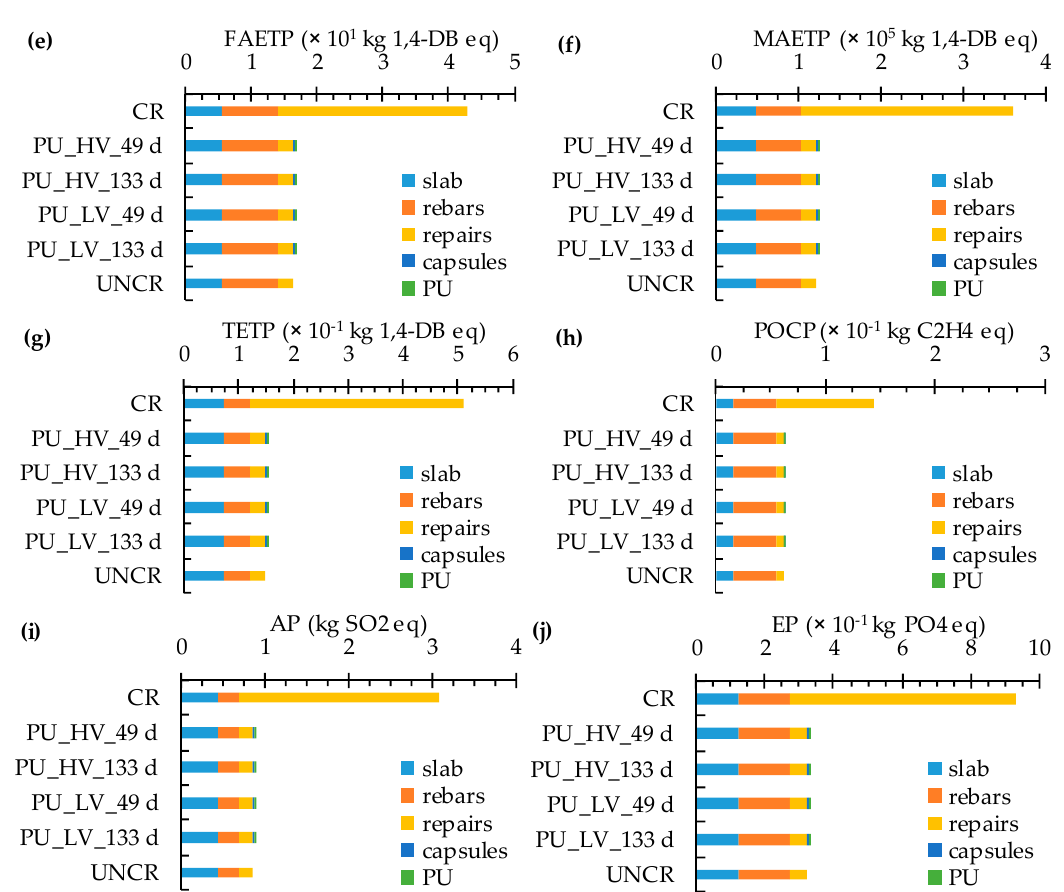
Figure 6. The ten CML-IA baseline impact category indicators for steel reinforced concrete slabs (variable load: 5 kN/m², design service life: 100 years, including repairs) made with (un)cracked and self-healing concrete with encapsulated PU_HV and PU_LV: ( a ) ADP; ( b ) GWP; ( c ) ODP; ( d ) HTP; ( e ) FAETP; ( f ) MAETP; ( g ) TETP; ( h ) POCP; ( i ) AP; and ( j ) EP.